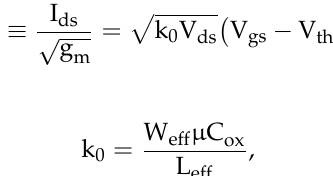
Figure 10. The trends of SS, DIBL, and V th with L g for triangular cross-sectional GAA SNWTs.